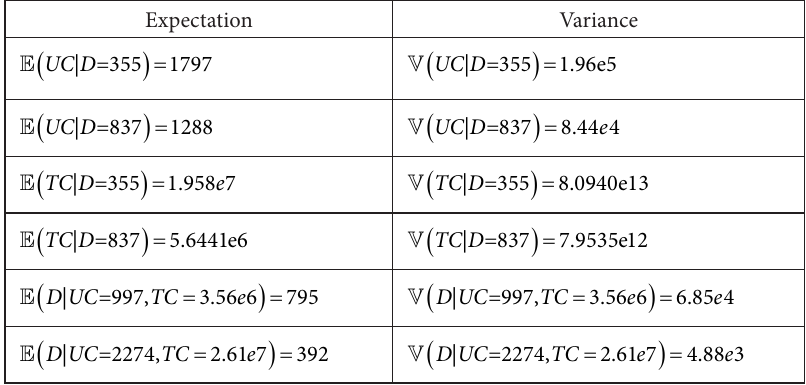
Table 7. Example results of conditional expectation and